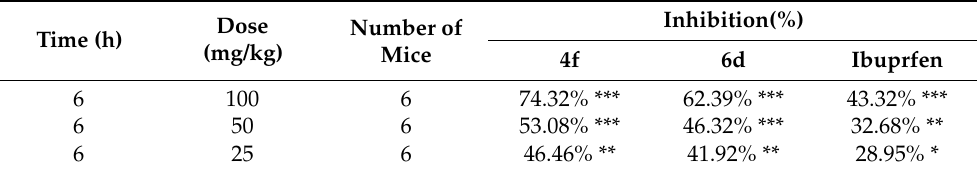
Table 6. In vivo anti-inflammatory activity of compounds 4f and 6d administered orally at different